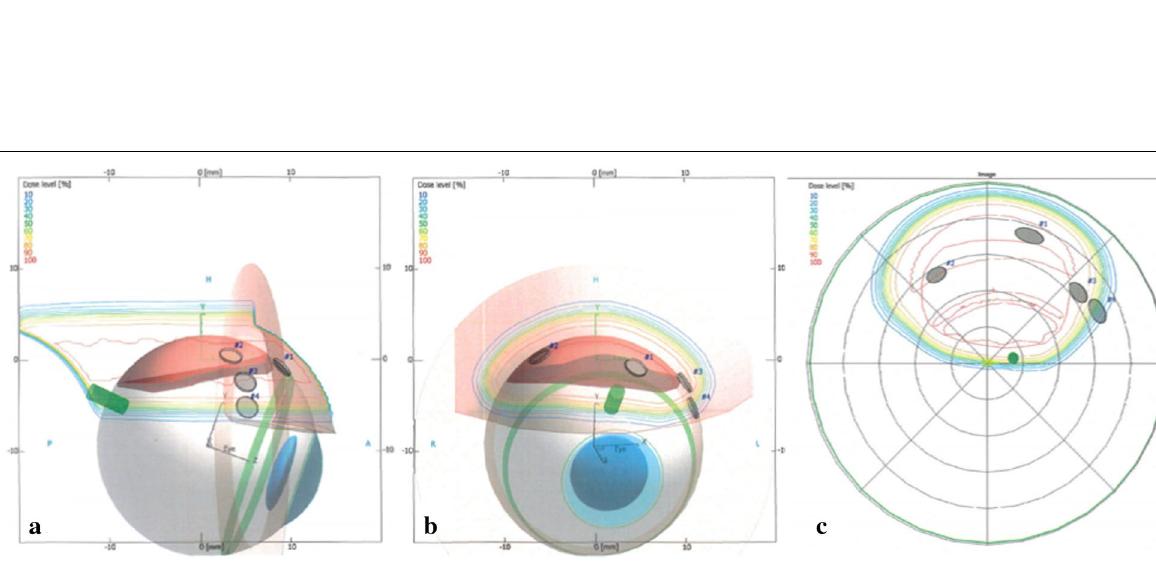
Fig. 2. 3D computer model of the patient’s eye/tumor for proton-beam radiotherapy. Eyeplan treatment planning system: ( a ) eye side, ( b ) beam axis and ( c ) optical-axis-centered fundus isodose